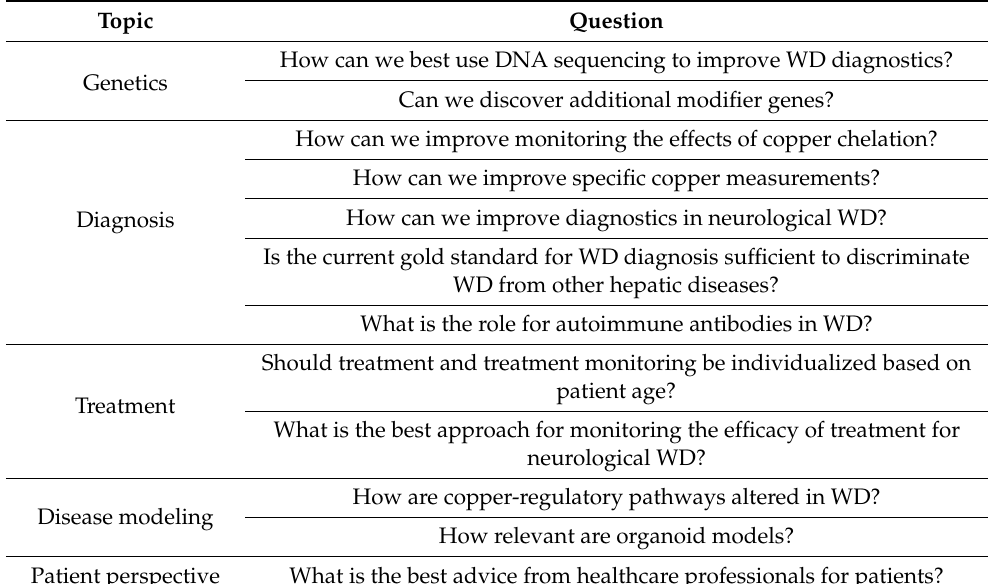
Table 1. The most important outstanding